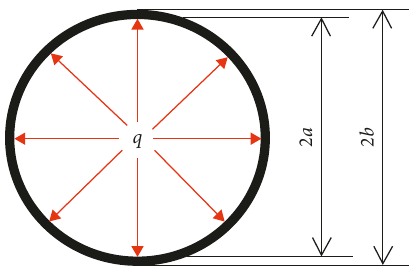
Figure 5: Force state diagram of steel sleeve subjected to passive confining pressure.